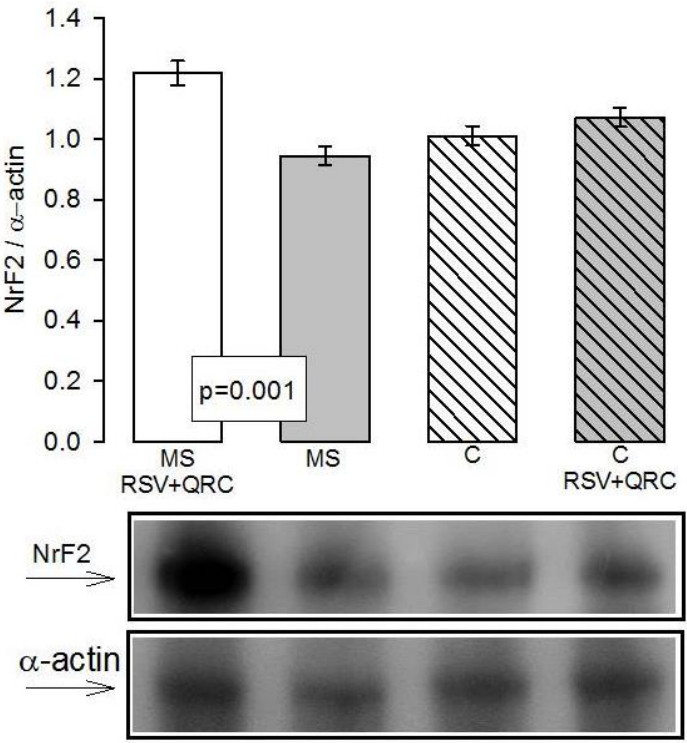
Figure 7. Effect of polyphenols on Nrf2 protein expression in liver homogenate from Control and MS experimental groups. A representative Western blot result is shown above the graphs. Data are means ± SE, n = 8 each group. Abbreviations: MS = metabolic syndrome, C = control, RSV = resveratrol, QRC = quercetin.